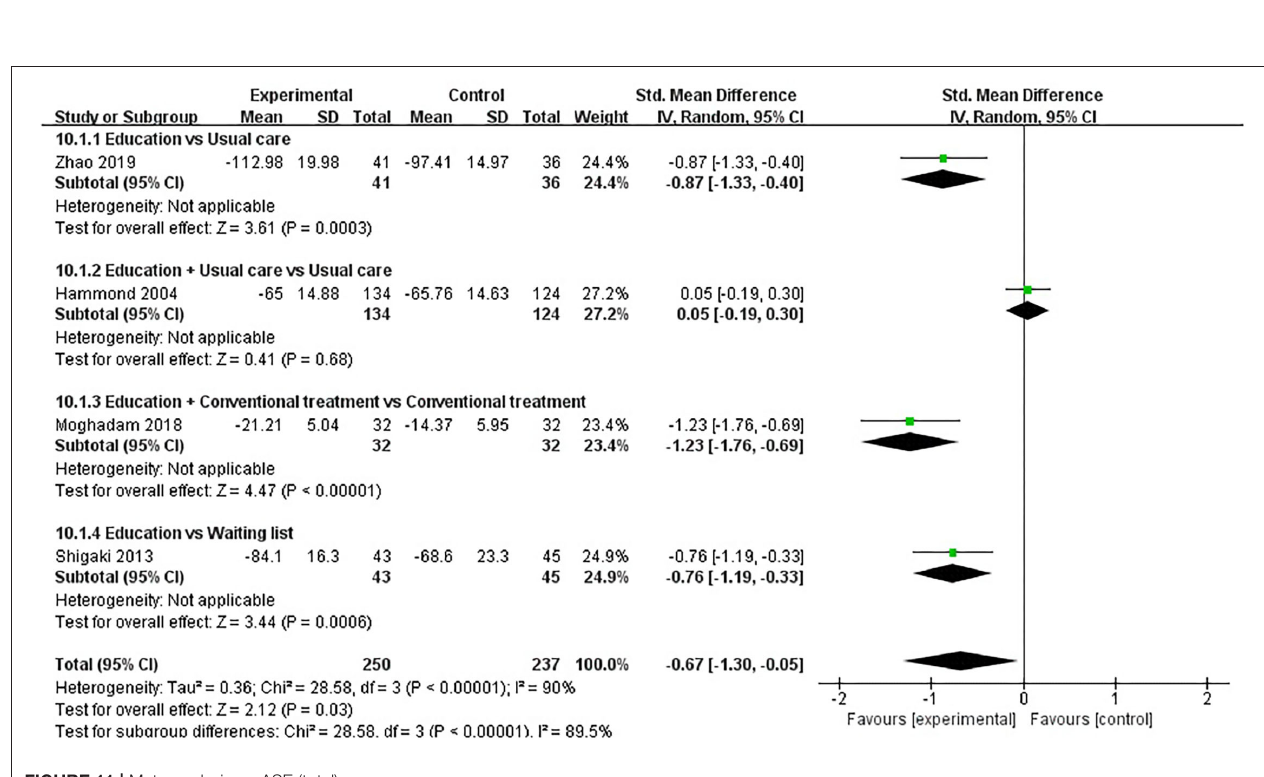
FIGURE 11 | Meta-analysis on ASE